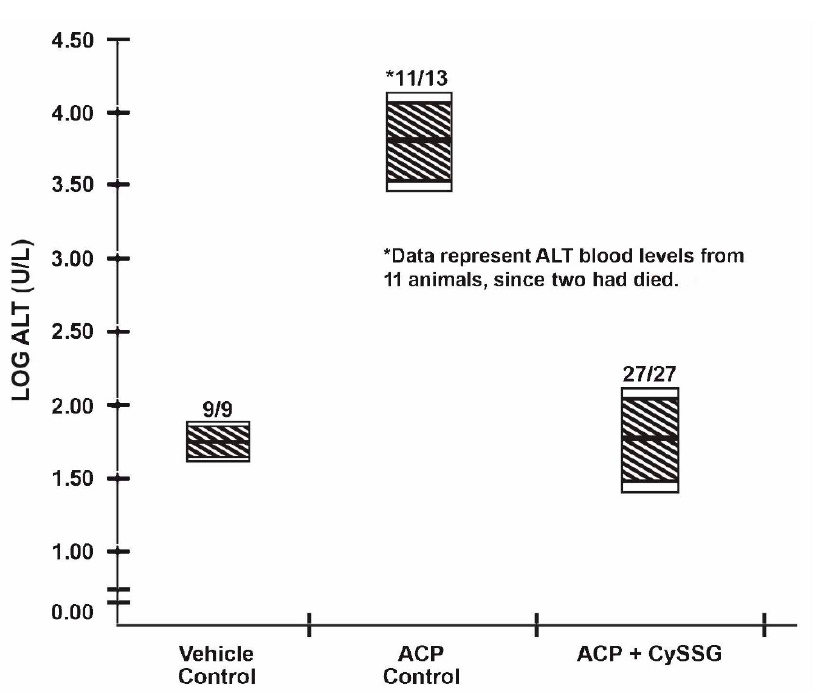
Figure 1. Alanine transaminase (ALT) levels of mice treated orally with CySSG.